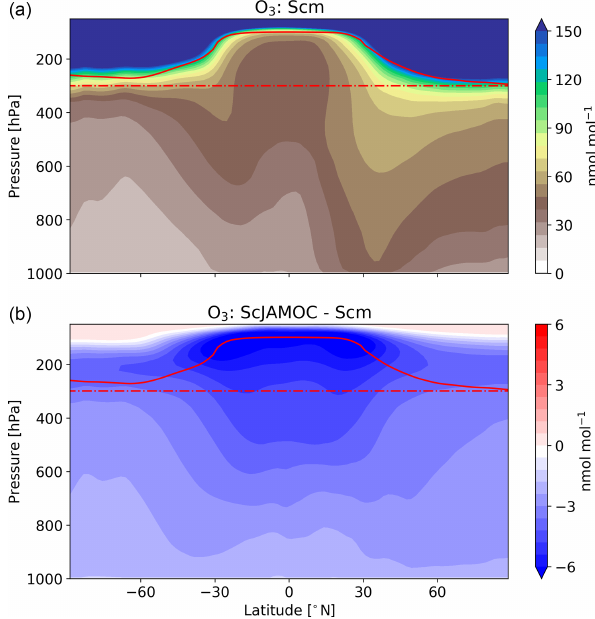
Figure 10. Mean zonal O 3 mixing ratios for Scm (a) and in com- parison to ScJAMOC (b) . The characteristics of each simulation are provided in Table 1. The yearly mean tropopause is depicted by a solid red line. In addition, the 300hPa tropopause layer used for the O 3 IASI-FORLI comparison (see Fig. 11) is depicted by a dash- dotted red